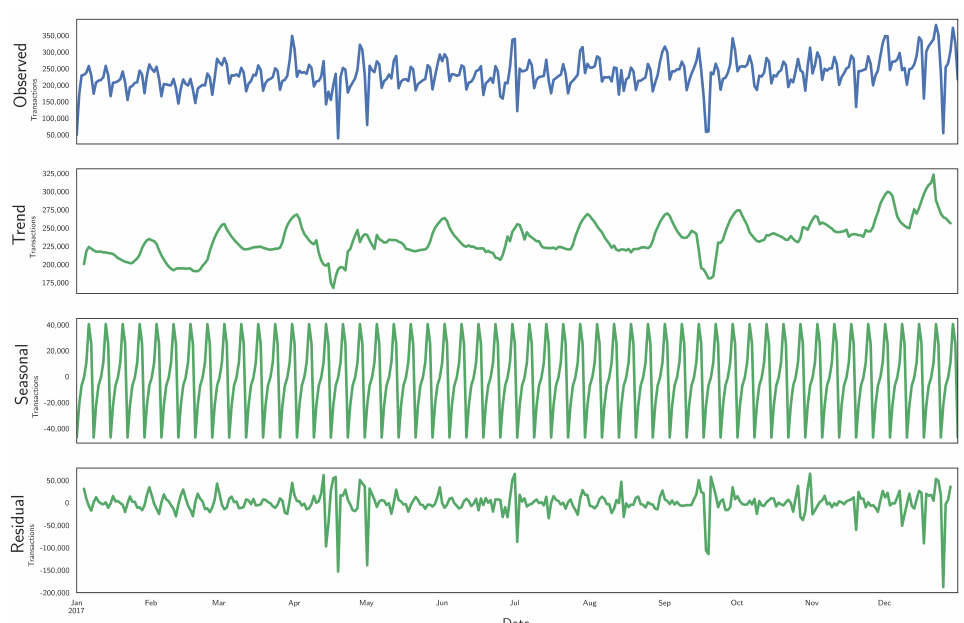
Figure 5. Decomposition of the aggregated CCR time series into trend, seasonal, and residual